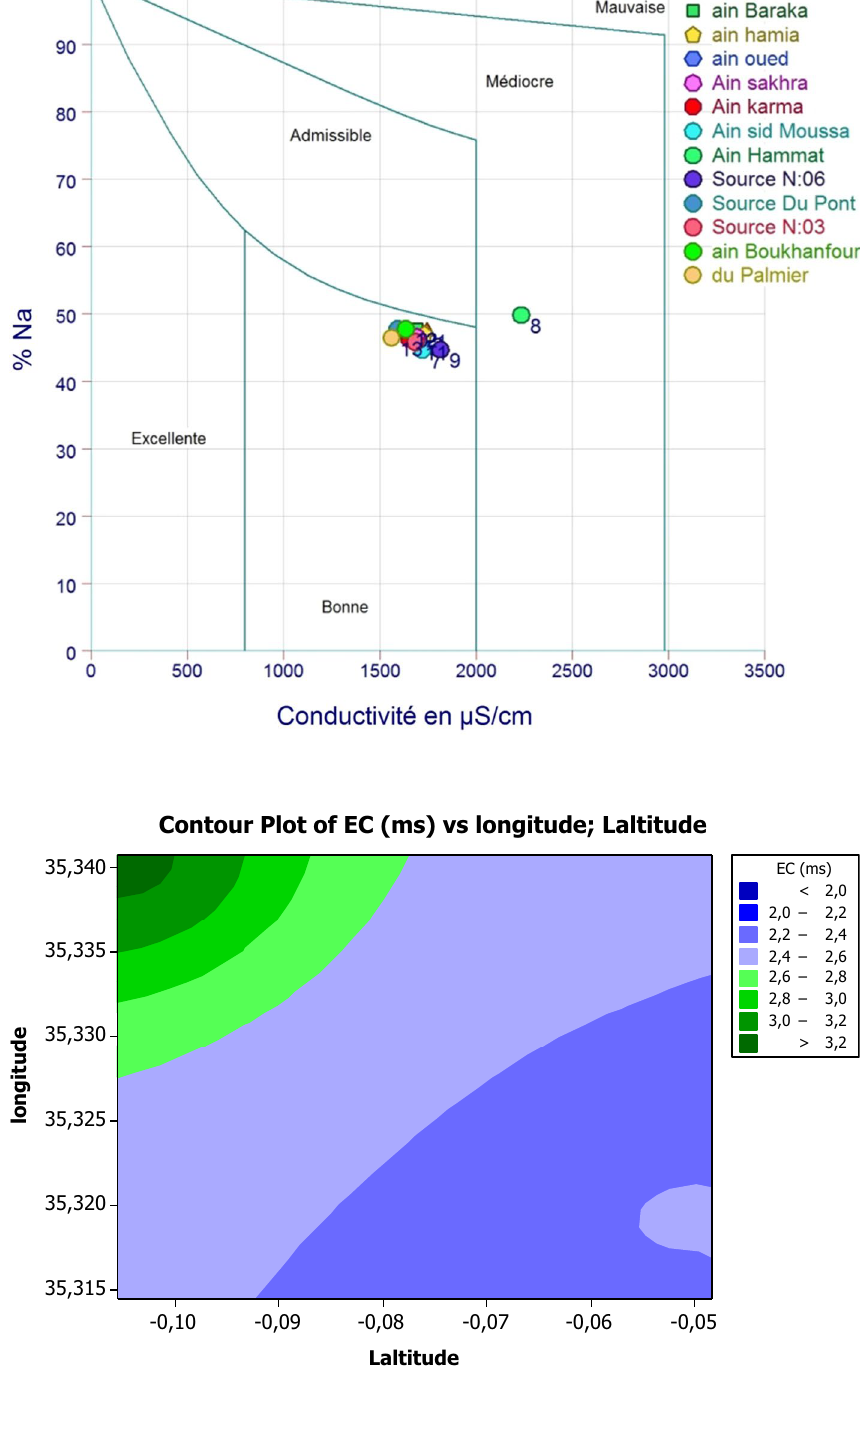
Fig. 6 Wilcox plot show water quality in function of conductiv- ity and sodium %